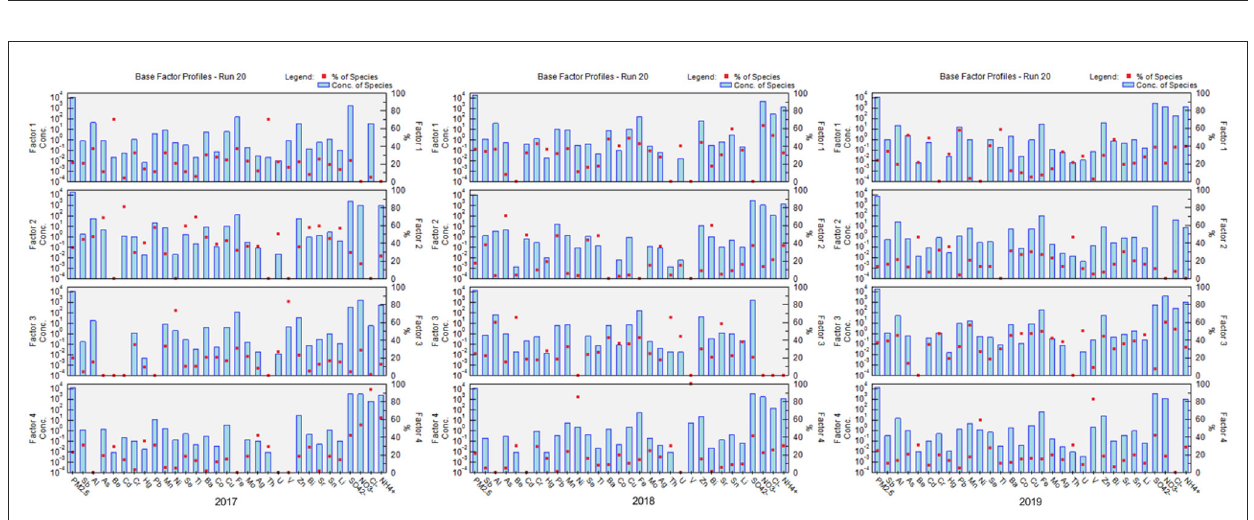
FIGURE2 Positive matrix factorization (PMF) analysis of the distribution of sources of PM 2.5 -bound metal from 2017 to 2019. Red dot means percentage ratio of each kind of species, blue bar means concentration of each species.